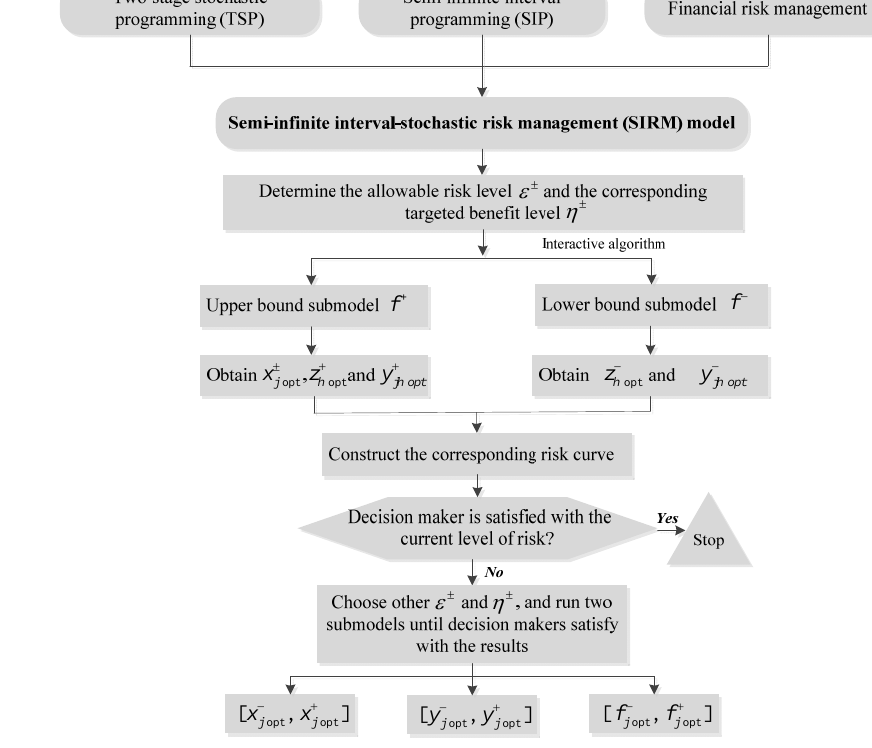
Figure 1. Overall flow chat of the methodology.